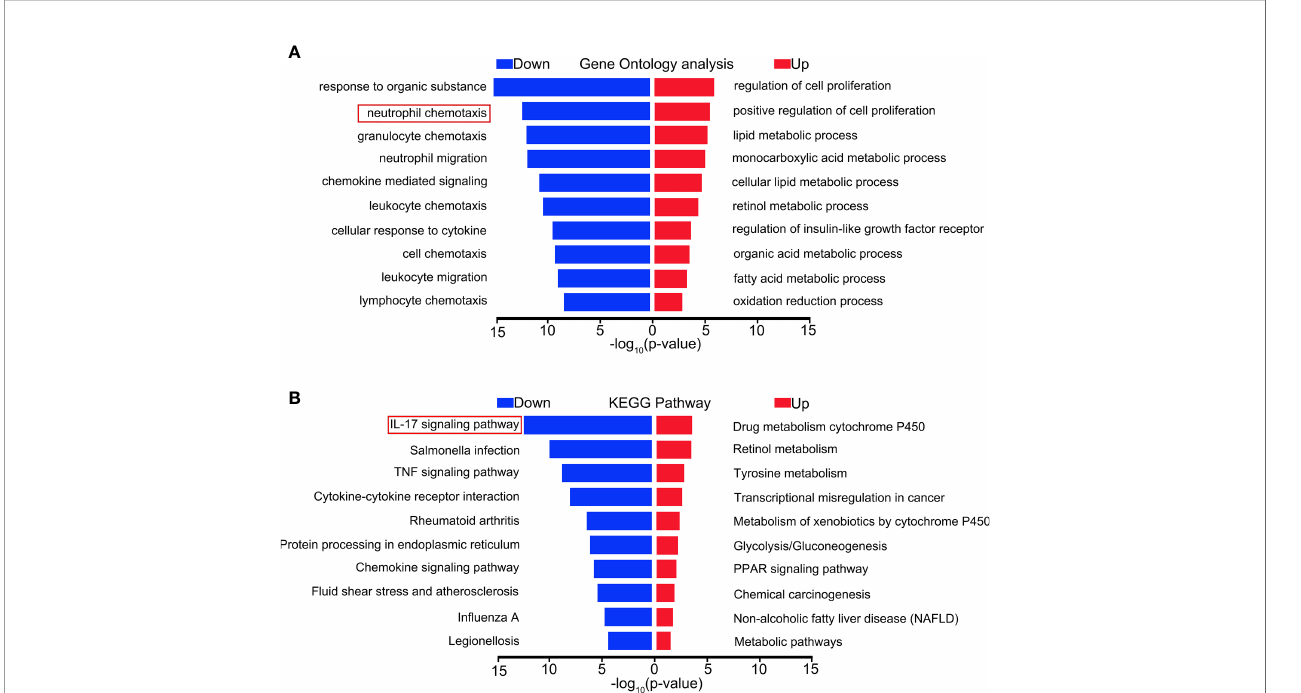
FIGURE 2 | Distinct transcriptional signature between LPS and LPS + MCTR1 groups. 12 h after LPS treatment, the hearts were harvested and the transcriptome were analyzed by RNA Sequencing (RNA-Seq) technology between LPS and LPS + MCTR1 groups. Signi fi cance of differentially expressed genes was divided into UP- and DOWN-regulated gene lists. UP and DOWN genes were submitted for gene ontology (GO) analysis (A) and Kyoto encyclopedia of genes and genomes (KEGG) pathway enrichment analyses (B)